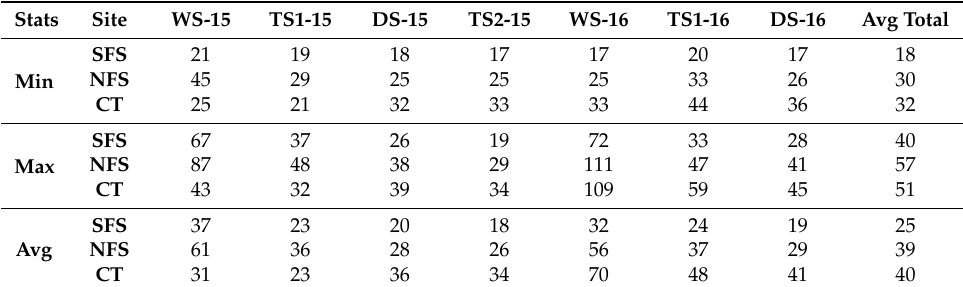
Table 2. Comparison of statistical values of SWS (mm) of each site and hydrological season up to 1 m depth at NFS and CT and 0.4 m at SFS: Min (minimum), Max (maximum), Avg (average), and Avg total (total average).